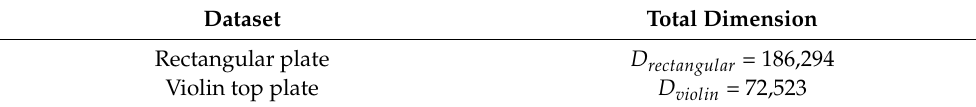
Table 1. Dimension of the datasets. Dataset Total Dimension Rectangular plate D rectangular = 186,294 Violin top